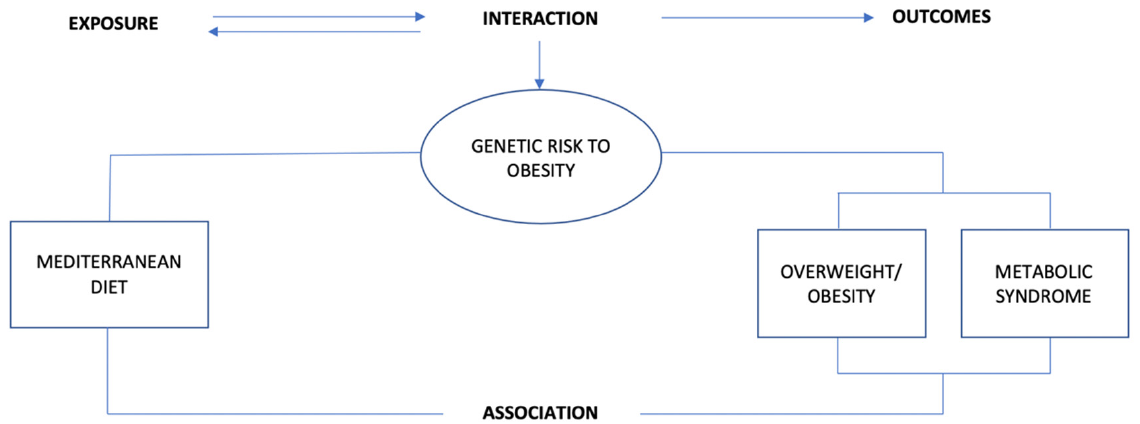
Figure 1. Conceptual framework of the present narrative review.